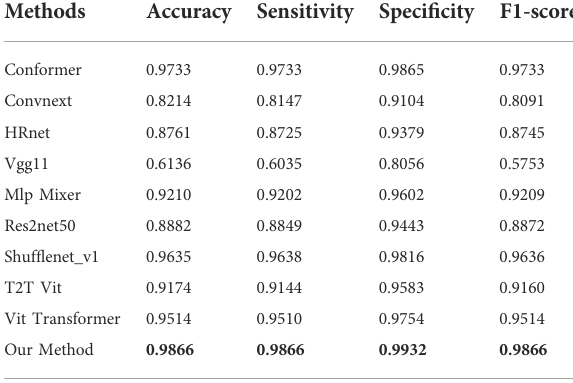
TABLE 2 Comparing the existing methods of binary classi fi cation for macular edema. Methods